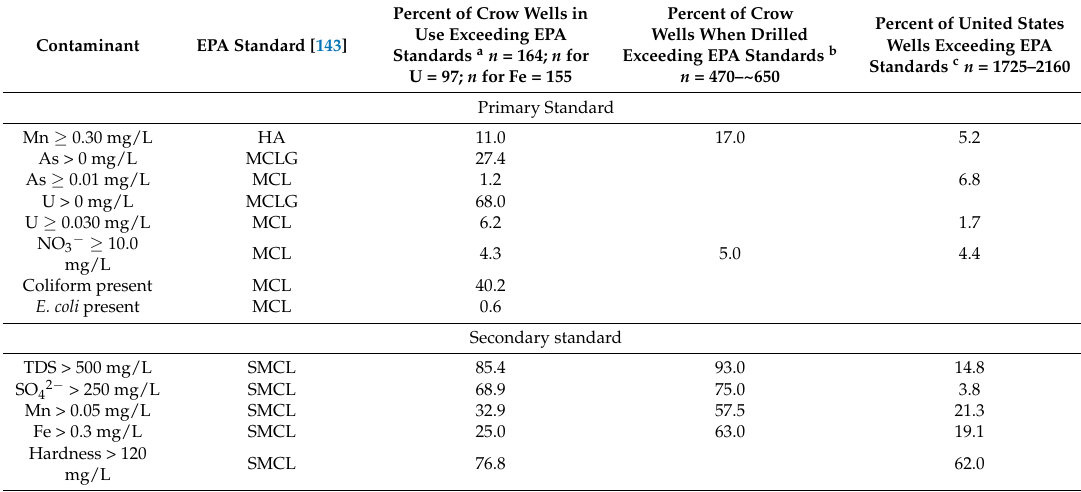
Table 4. Percentages of wells exceeding primary and secondary standards, locally and nationally. Empty cells indicate that no data were available.